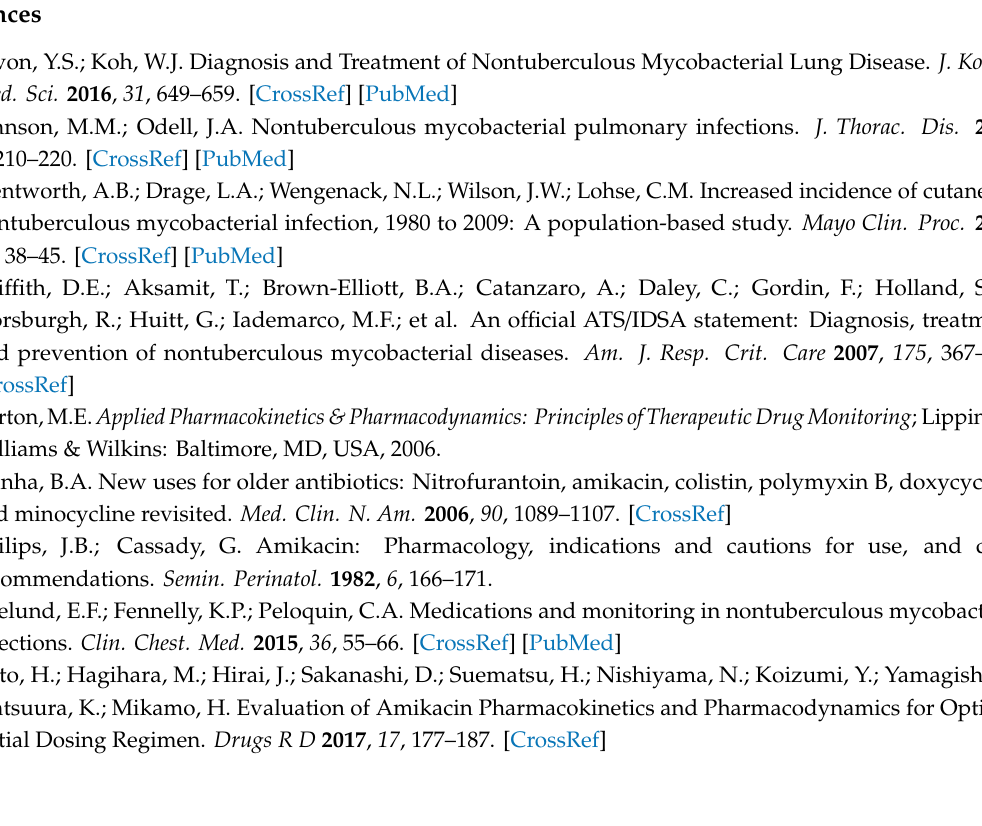
Table S1: Sequential covariate model